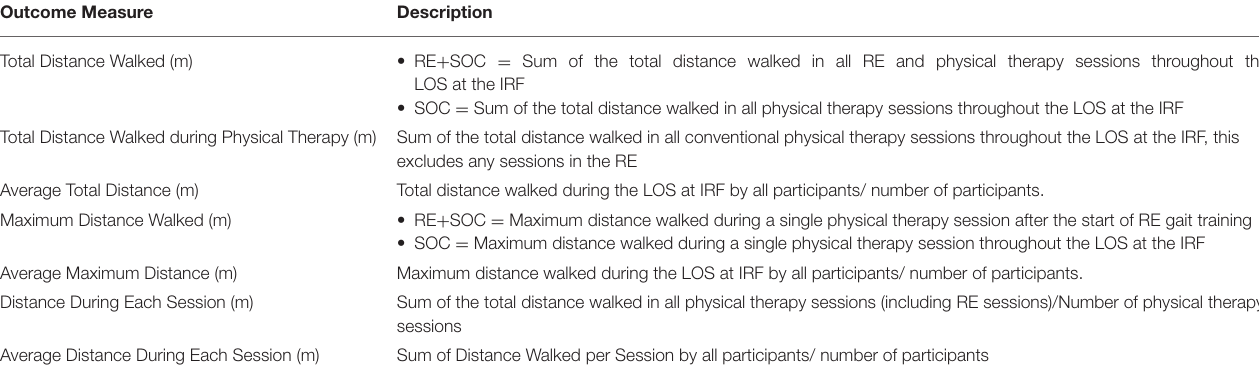
TABLE 2 | Distance outcome measures. Outcome Measure Description